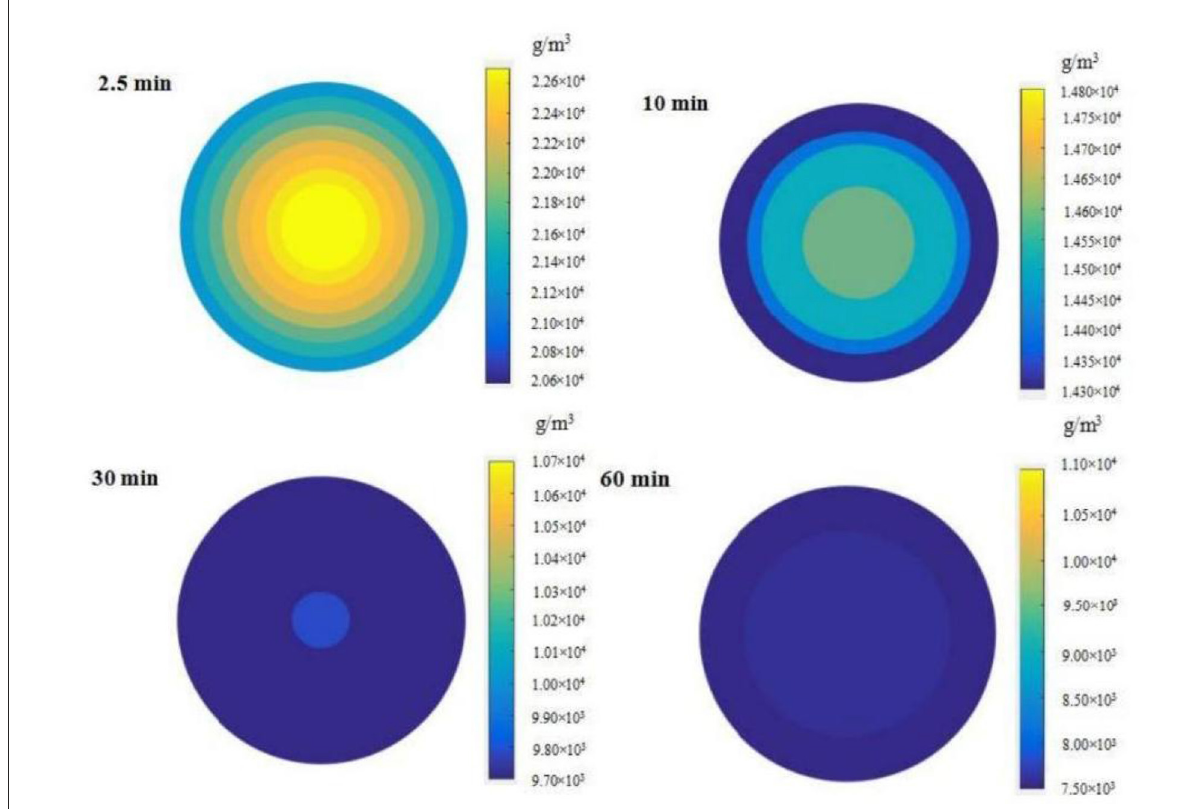
FIGURE8 Distribution of phenolics content within grape pomace at different extraction time points (Extraction conditions: 30 ◦ C and 96.1 W/L).